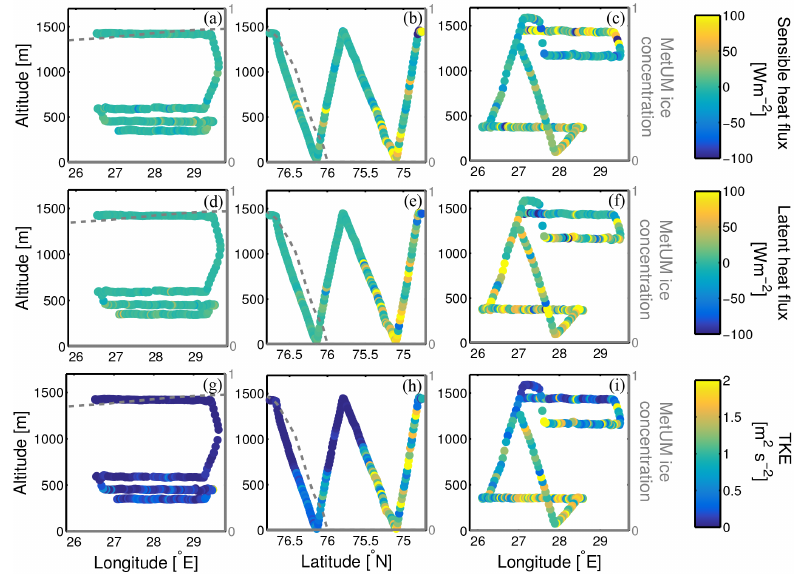
Figure 16. Sensible (a–c) and latent (d–f) heat fluxes and turbulent kinetic energy (TKE, g–i ) calculated at 10s intervals along the flight path. The path of the aircraft with respect to latitude (middle column) or longitude (left- and right-hand columns) is shown, with the measurements indicated in colour. The left column displays data from over the sea ice, whilst the middle and right columns show MIZ and ocean data respectively. Approximate MetUM sea ice fraction is shown (grey, dashed) over the sea ice and MIZ (left and middle columns), and is absent over the ocean (right